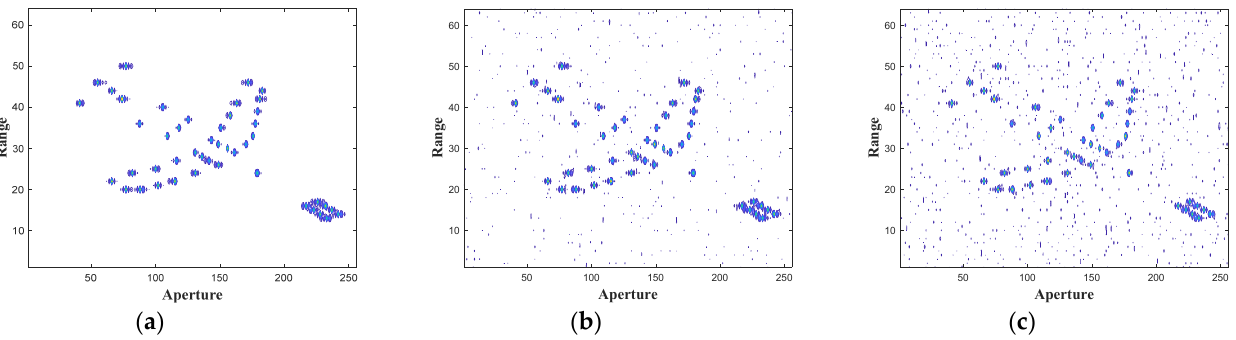
Figure 10. The recovered image applied the Relax method under different SNR levels. ( a ) 20 dB. ( b ) 10 dB. ( c ) 5 dB.